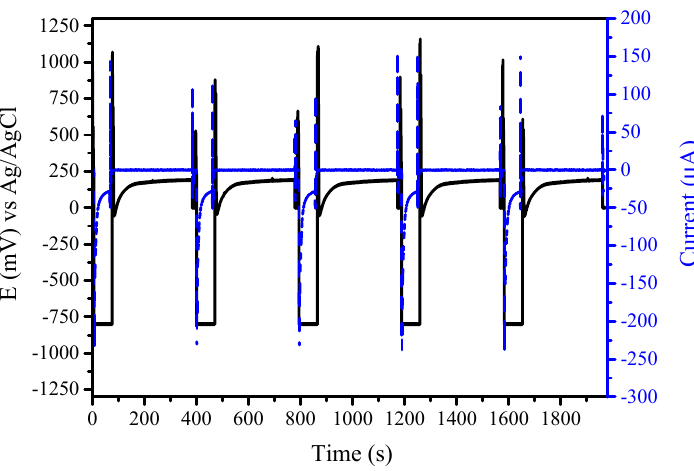
Figure 1. Cyclic voltammograms for the substrate in the Mn electrolyte with different pH values.